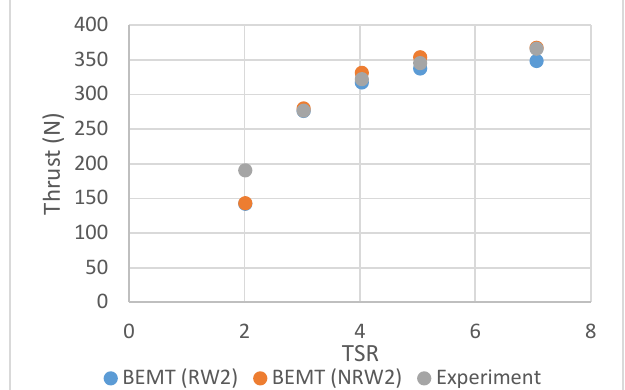
Figure 17. Thrust comparison between BEMT calculations and experimental data for inflow profiles with and without a turbine when the turbine operates under wave-current interactions with a wave height of approximately 0.09m and an apparent wave period of 0.5s. wave conditions at a TSR of 2 is approximately